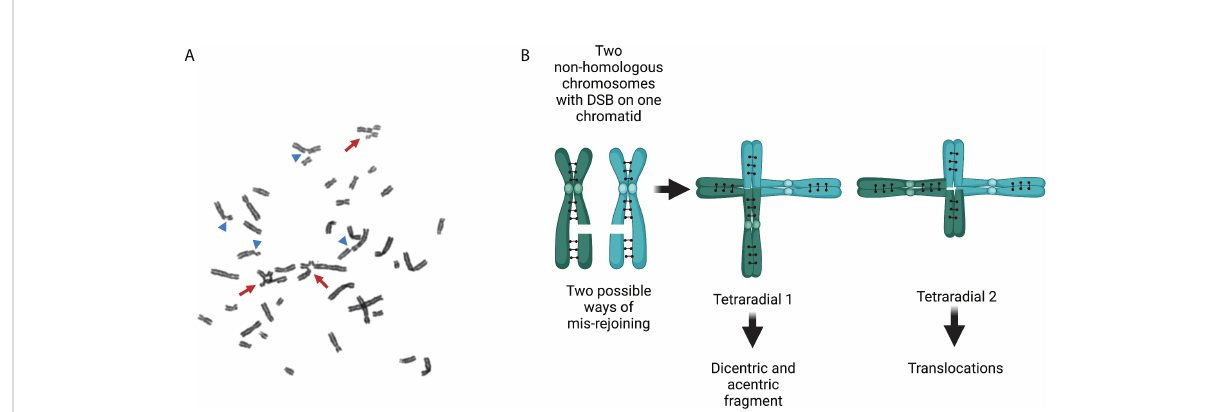
FIGURE 4 Chromosomal aberrations in Fanconi anemia. (A) Exposure of FA cells to ICL-inducing agents increases the number of structural chromosome aberrations and the number of aberrations per cell. Arrows show radial fi gures, and arrowheads show chromatid breaks; both are characteristic chromosomal aberrations found in FA cells. (B) Representation of two replicated non-homologous chromosomes with their sister chromatids linked by cohesins and each with a DSB in only one chromatid. Two types of radial fi gures may arise when the DSBs in two different replicated chromosomes are mis-rejoined. Tetraradial 1 results from the end joining of two chromosome proximal segments. Mitotic segregation of tetraradial 1 produces daughter cells with a dicentric chromosome and an acentric fragment (originated by the ligation of the two distal segments). Tetraradial 2 results from the joining of one proximal and one distal segment of two different chromosomes. Mitotic segregation of tetraradial 2 results in daughter cells with translocations. DSBs, double-strand breaks; FA, Fanconi anemia; ICLs, interstrand cross-links.